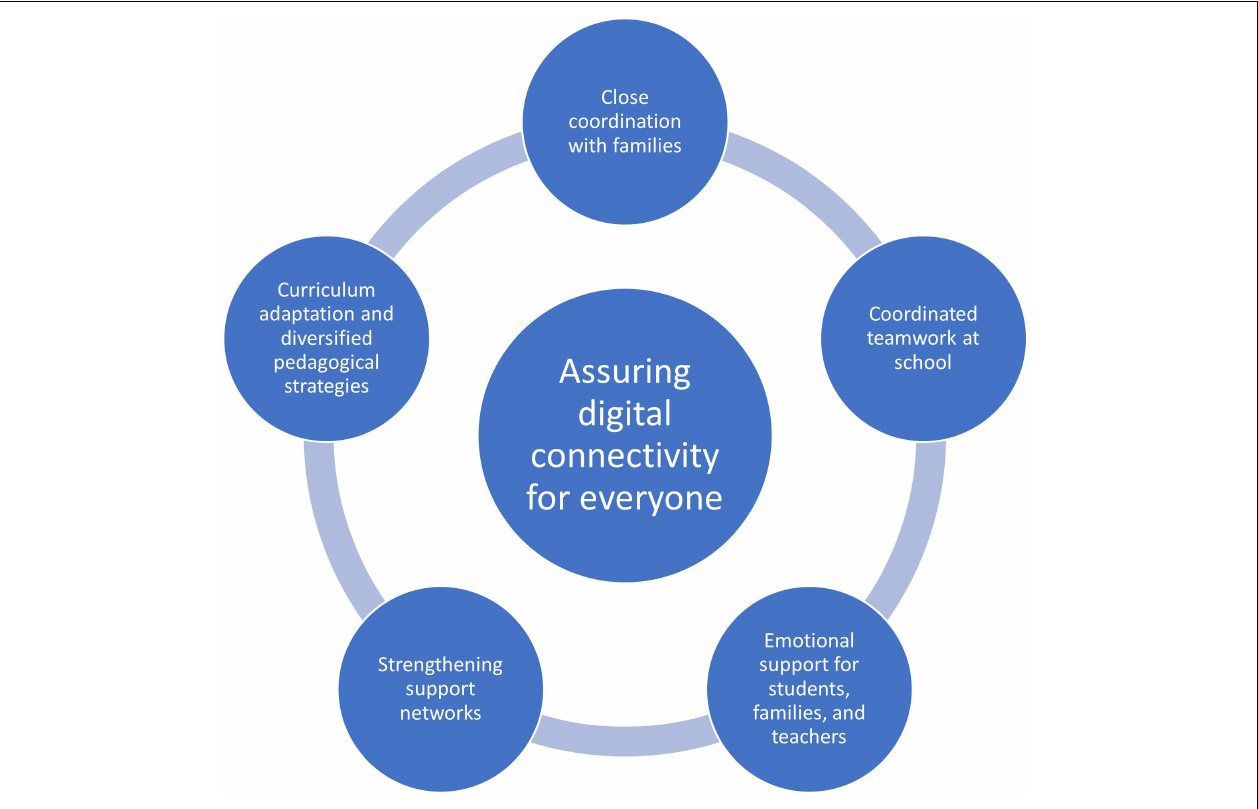
FIGURE 1 | Conditions for a collective, sustainable wellbeing of school communities during the school-closure period of the COVID-19 pandemic: Summary of research